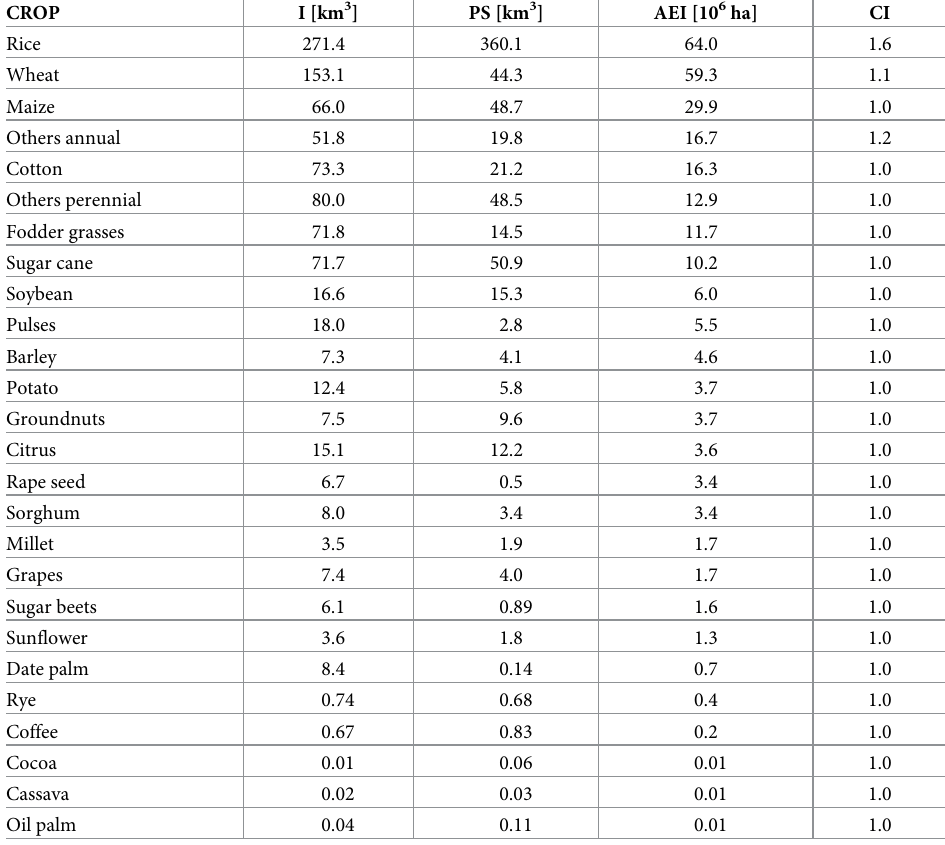
Table 2. Crop-related summary of estimations and irrigated areas. CROP